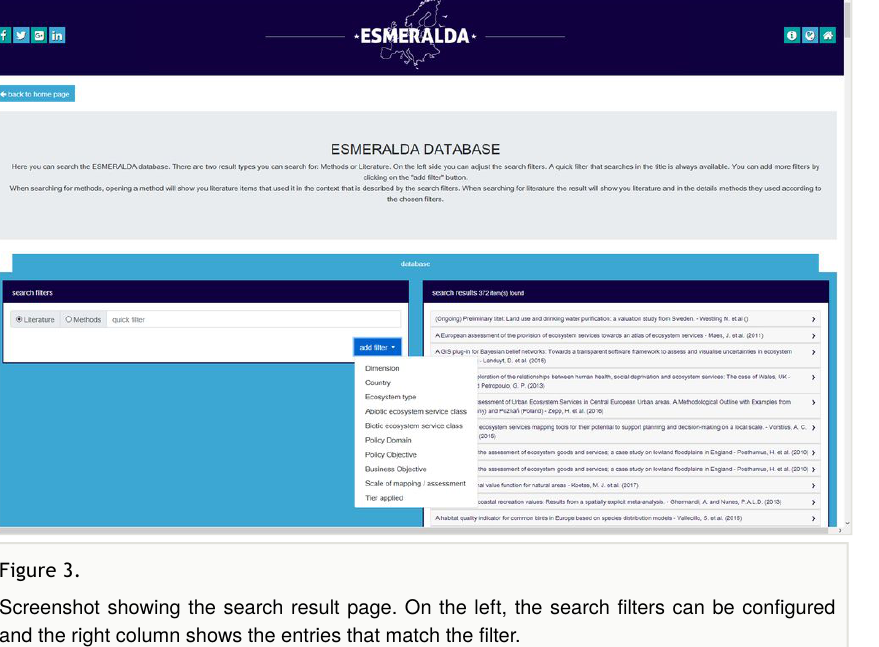
Figure 3. Screenshot showing the search result page. On the left, the search fi lters can be con fi gured and the right column shows the entries that match the fi